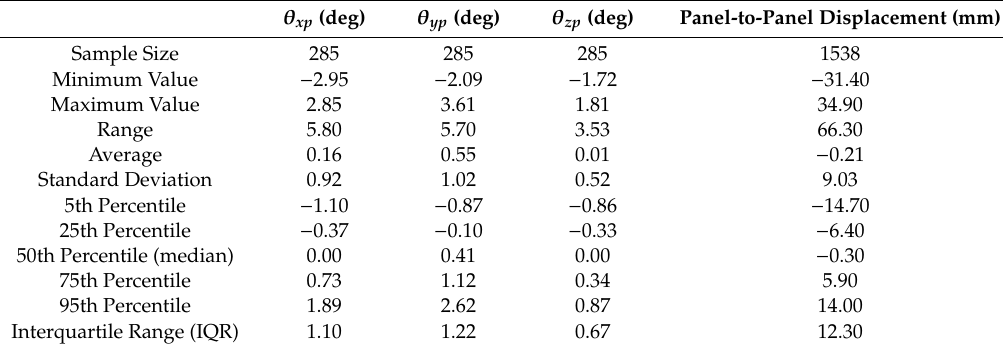
Table 12. MLS-based summary statistics of the serviceability measures for 285 panels of the MSE wall at